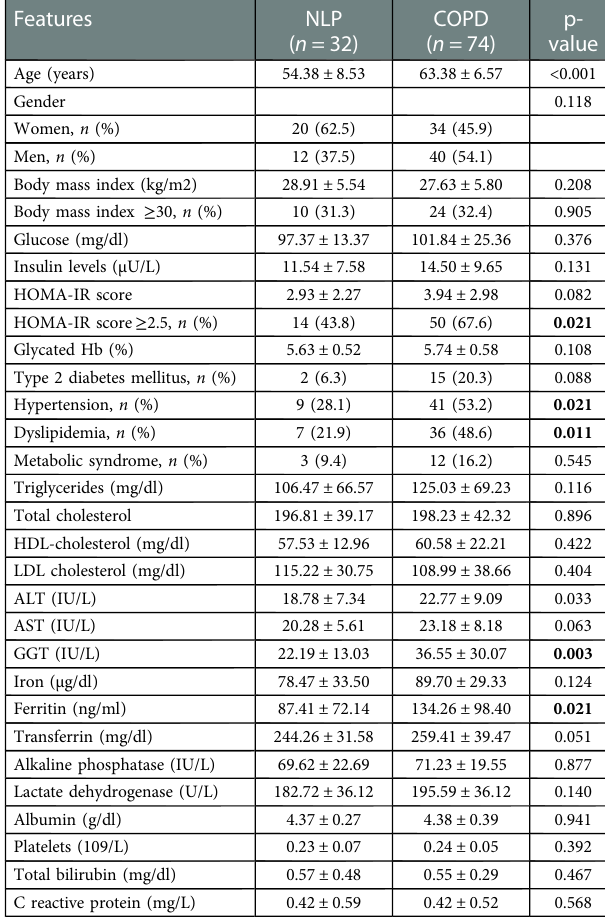
TABLE 1 Characteristics of the study